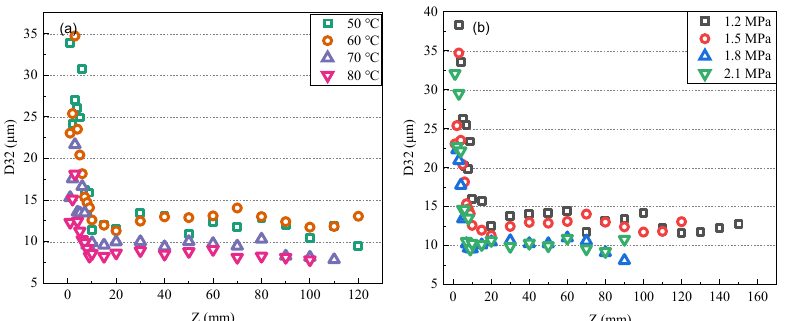
Figure 8. Effects of injection temperature and pressure on the variation of droplet D32 diameter along spray central axis. ( a ) Effect of T inj on D32 variation under P inj = 1.5 MPa; ( b ) Effect of P inj on D32 variation under T inj = 60 ◦